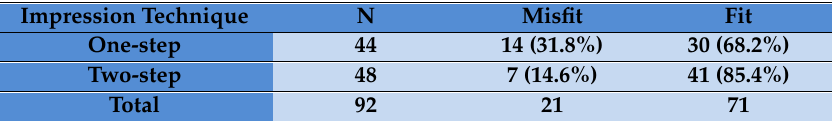
Table 1. Clinical result for impression